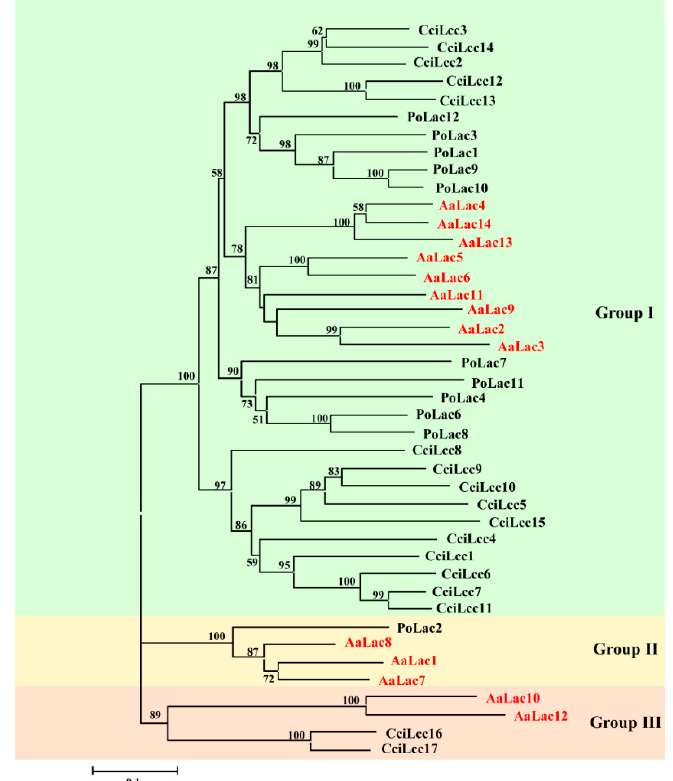
Figure 4. The phylogenetic tree of laccase proteins from A. areolatum , C. cinerea and P. ostreatus . The tree was constructed by MEGA 6.0 using NJ method with bootstrap replication of 1000 times. The laccases of C. cinerea (CciLcc1–CciLcc17 with GeneBank accession numbers DAA04506–DAA04522) and P. ostreatus (PoLac1 with JGI Protein ID 1043420; PoLac2 with JGI Protein ID 1067328; PoLac3 with JGI Protein ID 1102751; PoLac4 with JGI Protein ID 1077328; PoLac6 with JGI Protein ID 1113032; PoLac7 with JGI Protein ID 1077468; PoLac8 with JGI Protein ID 1106925; PoLac9 JGI with Protein ID 1089733; PoLac10 with JGI Protein ID 1089723; PoLac11 with JGI Protein ID 1043488; PoLac12 with JGI Protein ID 1094965).